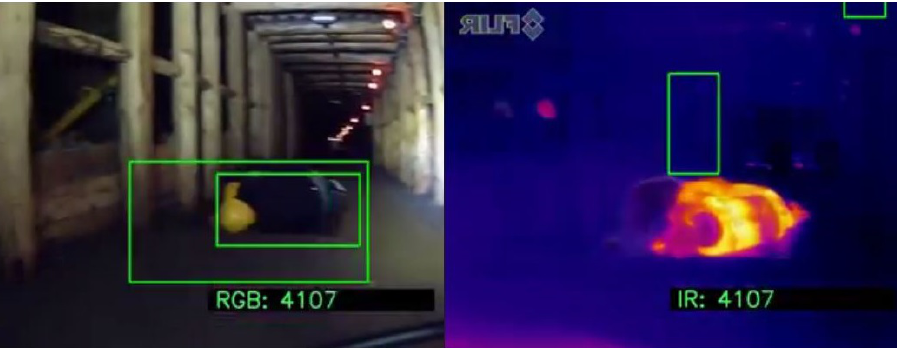
Figure 19. Human lying—correct (doubled) detection in RGB image, false detection in the IR image with algorithm HOG.